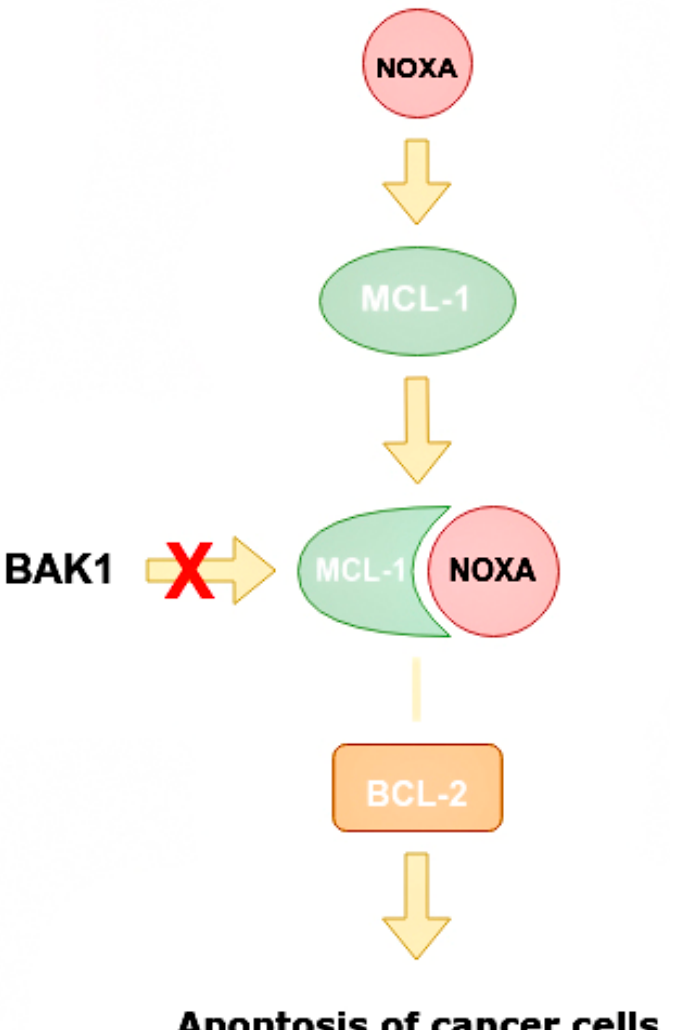
Figure 8. Mechanism of increasing apoptosis of cancer cells when miR-4728 does not inhibit NOXA. NOXA displaces BAK1 from MCL-1 as they have a similar conformation. The MCL-1/NOXA complex activates BCL-2, which activates the apoptosis of cancer cells. NOXA—NADPH oxidase activator, MCL-1—mantle cell lymphoma 1 protein, BCL-1—B cell lymphoma 1 protein, BCL-2—B cell lymphoma 2 protein, BAK1—BCL-2 homologous antagonist killer.